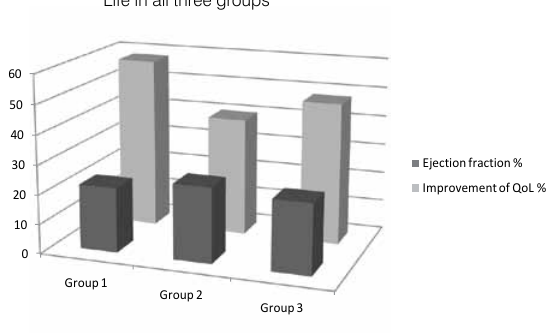
Figure1. Estimated Ejection Fraction and improvement of Quality of Life in all three groups